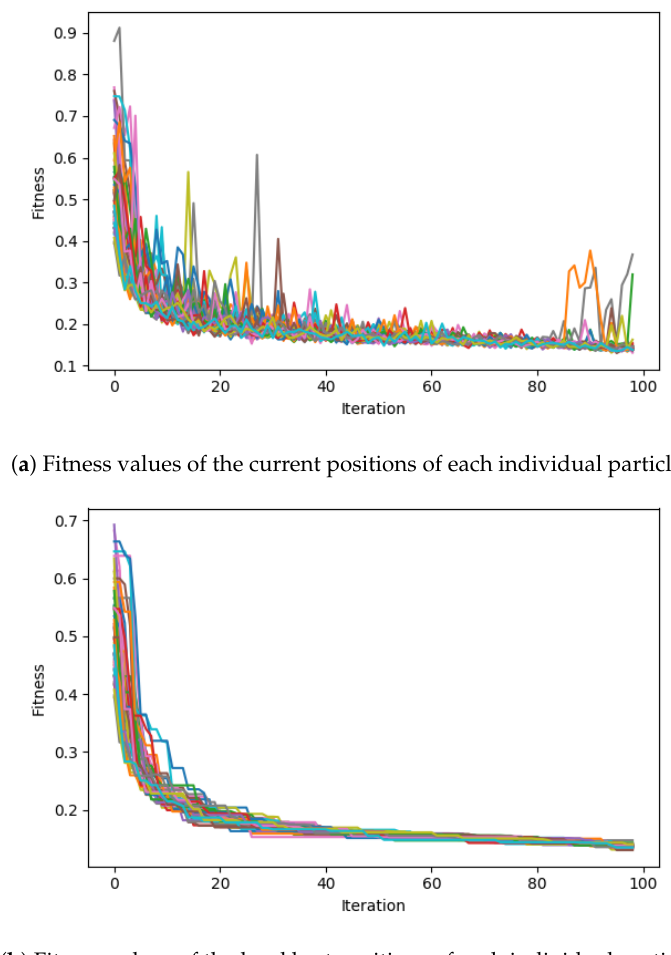
Figure 6. Fitness values for the current and local best positions of each individual particle throughout the optimisation process using the BLSK-NS weight inheritance method.